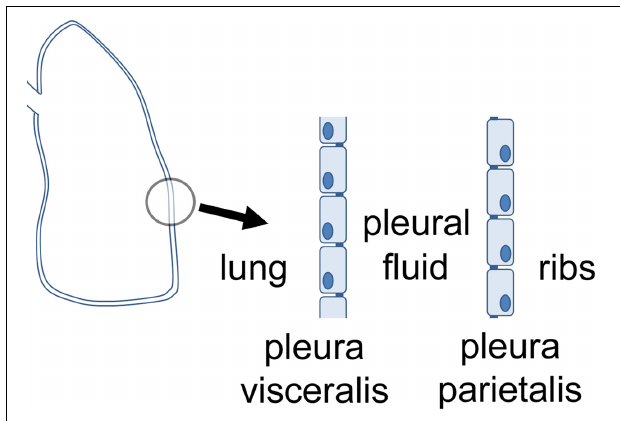
FIGURE 1 | Orientation of visceral and parietal pleura mesothelium.